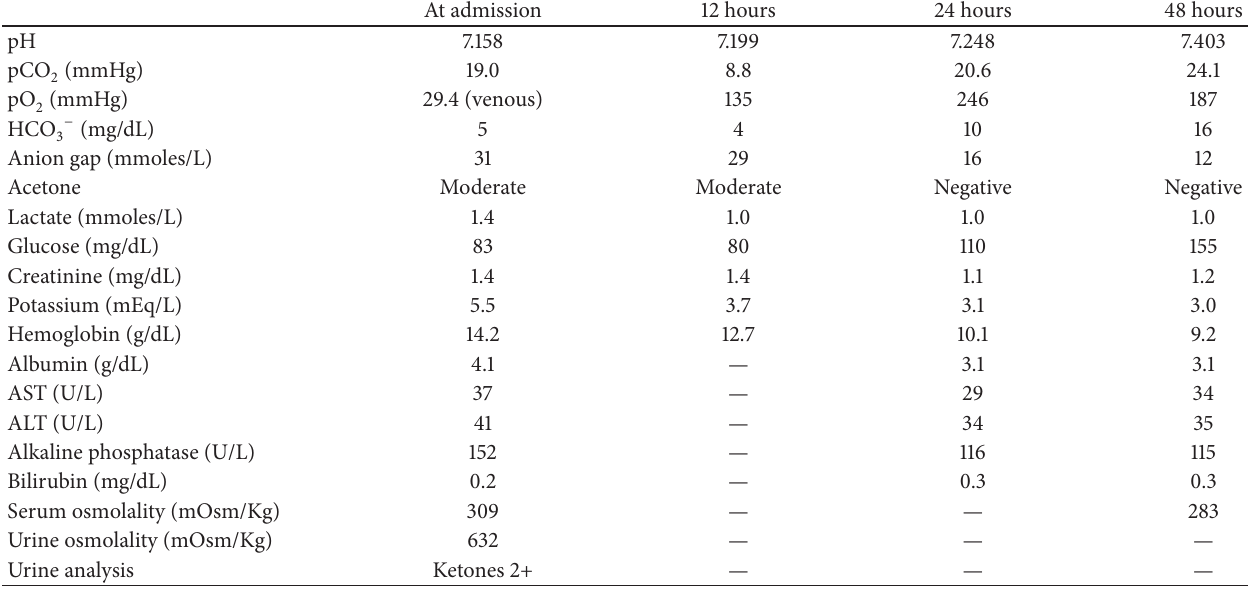
Table 1: Laboratory